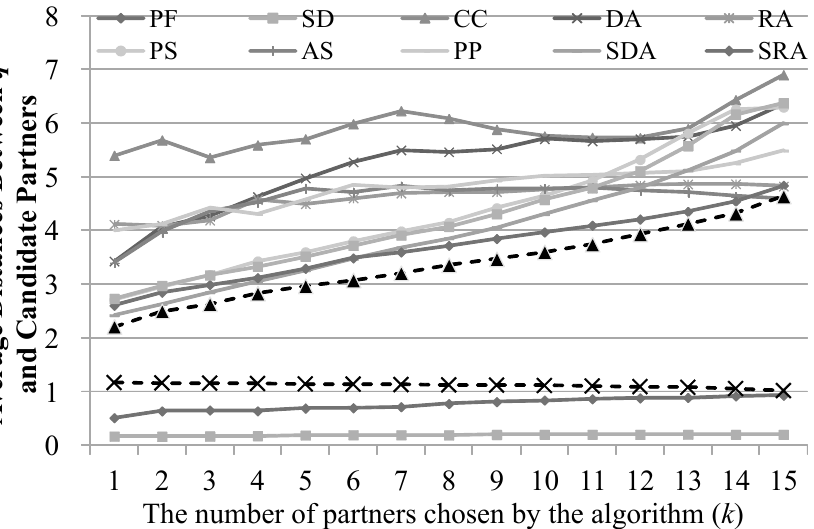
Figure 13. Average distances between q and candidate partners as derived by various methods.